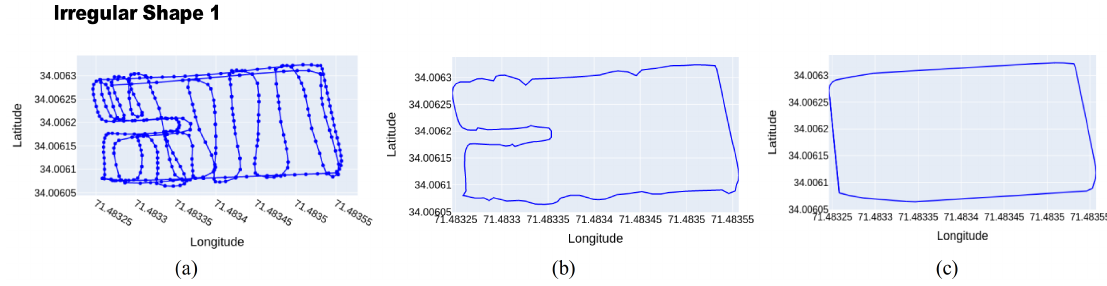
Figure 4. Comparison of boundary detection algorithms ( a ) Actual GPS Plots, ( b ) concave hull using KNN and ( c ) convex hull using Delaunay Triangulation.